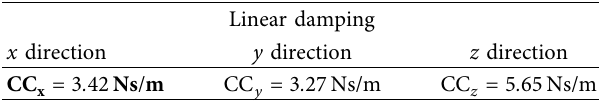
Table 3: Damping coefficients of the white coupling, as obtained